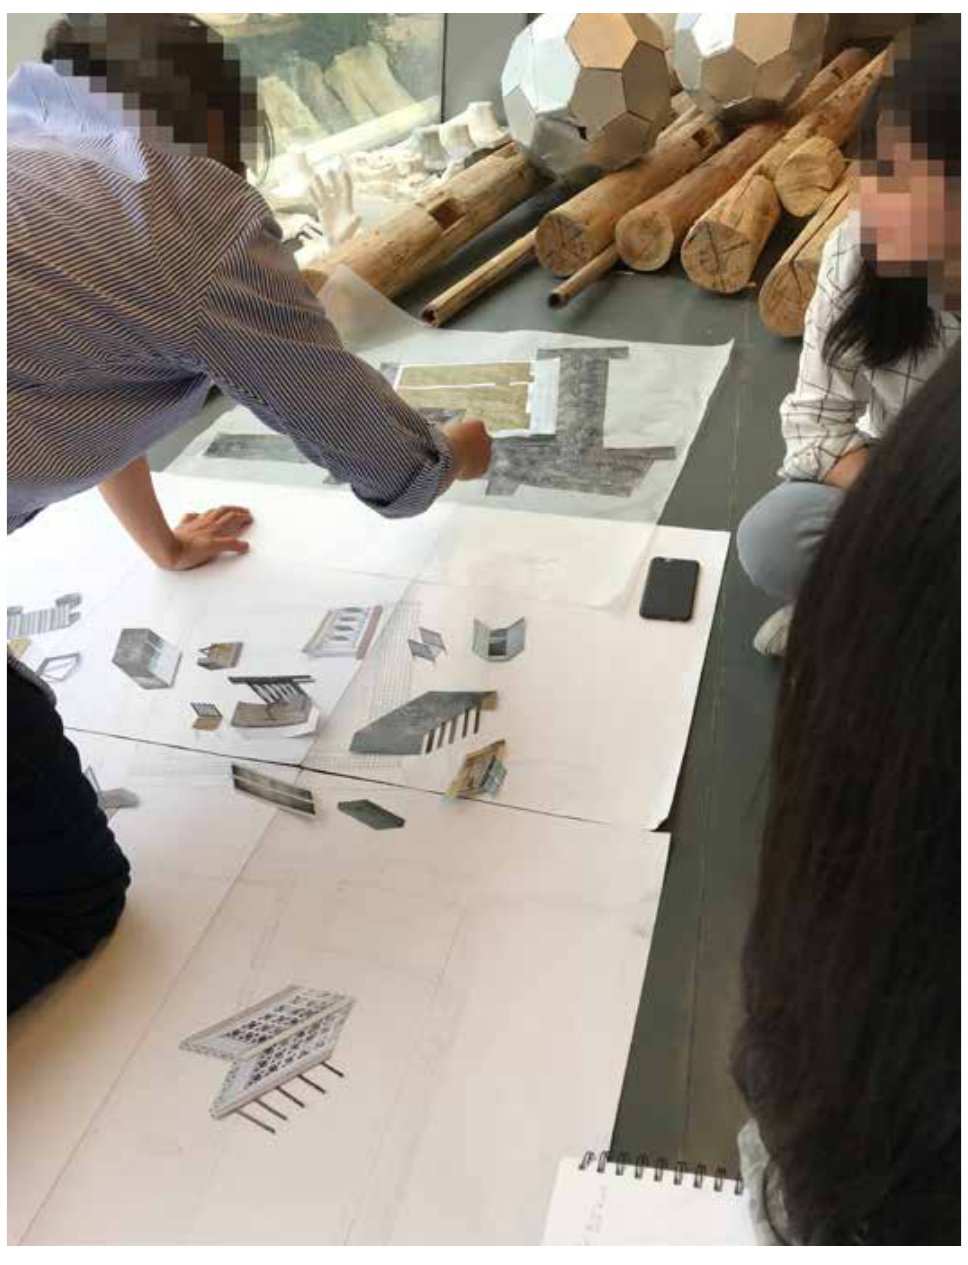
Figure 1: Exploring haptic interfaces in the context of blended learning settings. Testing spatial and elemental possibilities and their digital translations. Source: author.